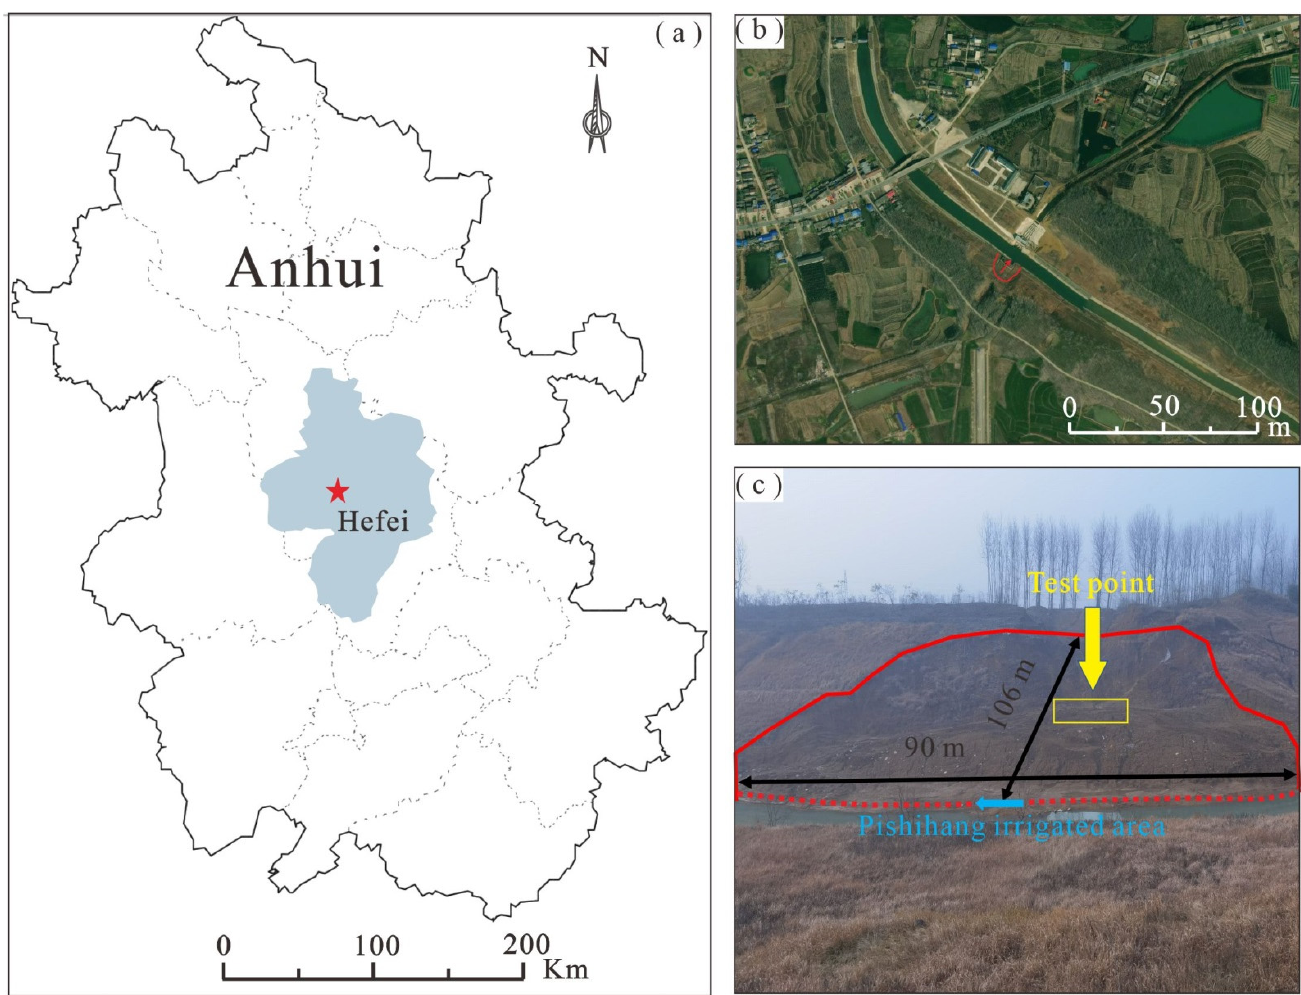
Figure 3. Location and geological map of the study area: ( a ) location of the study area; ( b ) satellite image of the slope (the base map was produced courtesy of Google Earth); and ( c ) overall view of the slope.